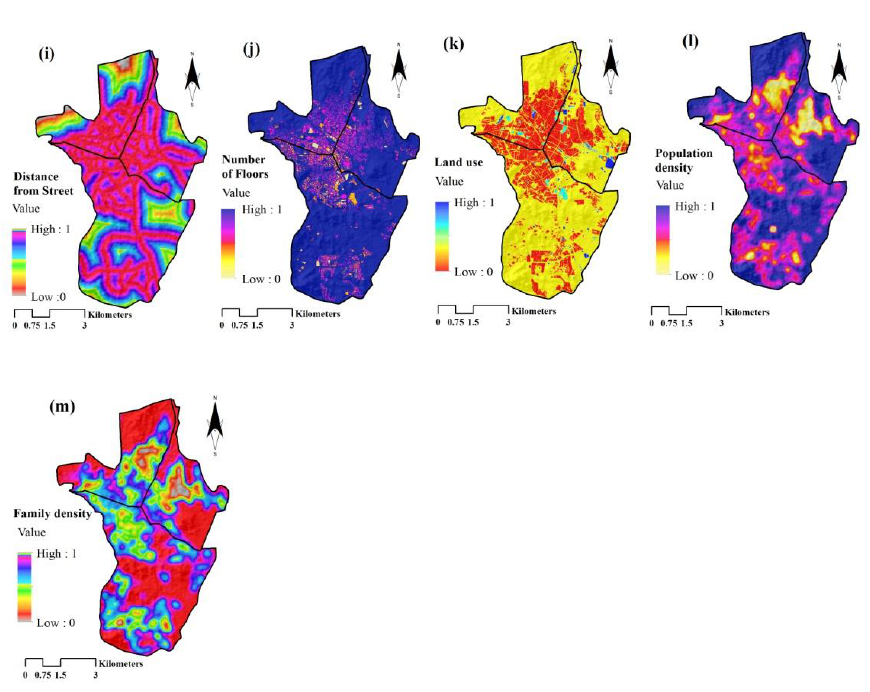
Figure 3. The Environmental, Physical, and Social layers used in the study.